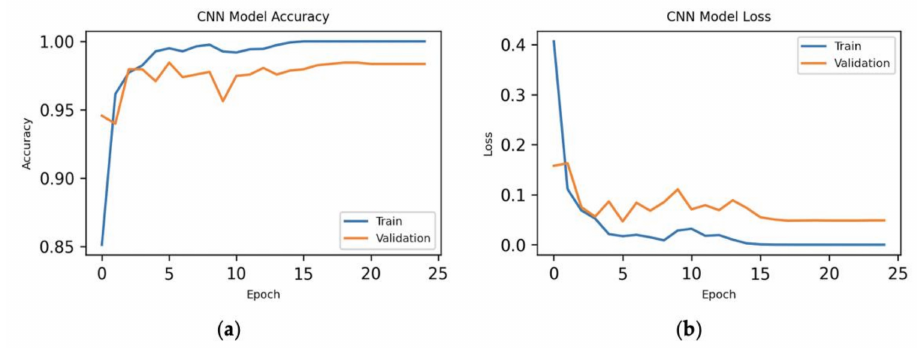
Figure 6. Experimental results for all the features: ( a ) epoch vs. accuracy and ( b ) epoch vs. loss.